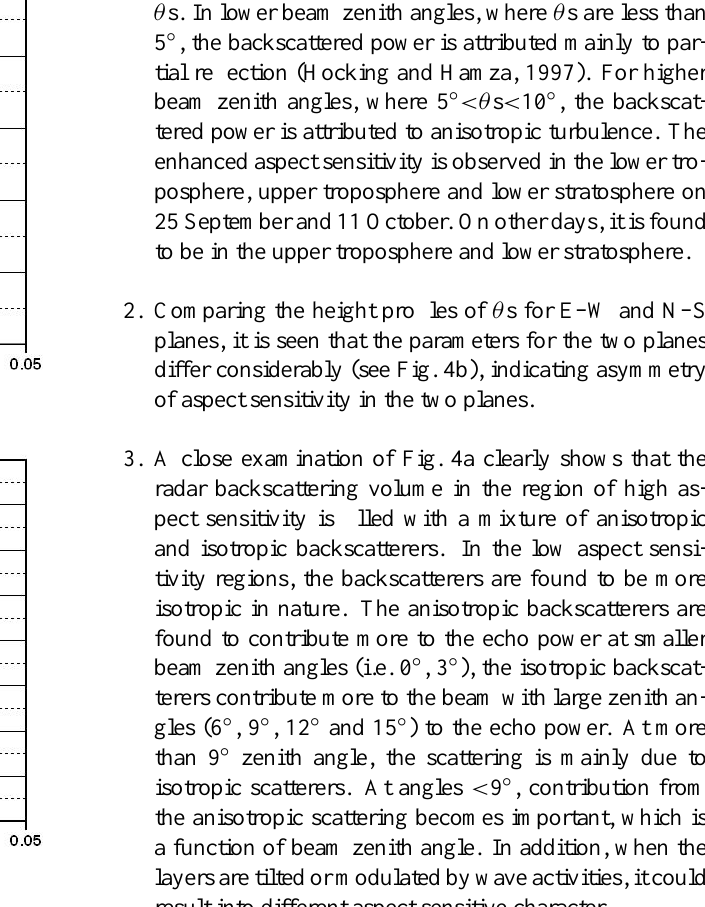
Fig. 3. Scatter plots of aspect sensitivity as a function of wind shear for height region of ( a ) < 15km and ( b ) > 15km where aspect sen- sitivity is